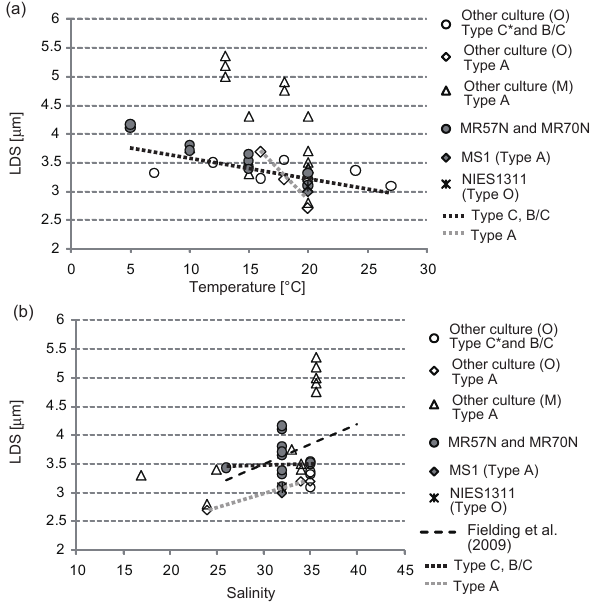
Figure 9. Relationships between LDS and cell diameter changed during growth (a) and LDS and salinity during growth (b) in various strains of E. huxleyi , including MR strains and other strains reported Figure 8. Saruwatari et al.